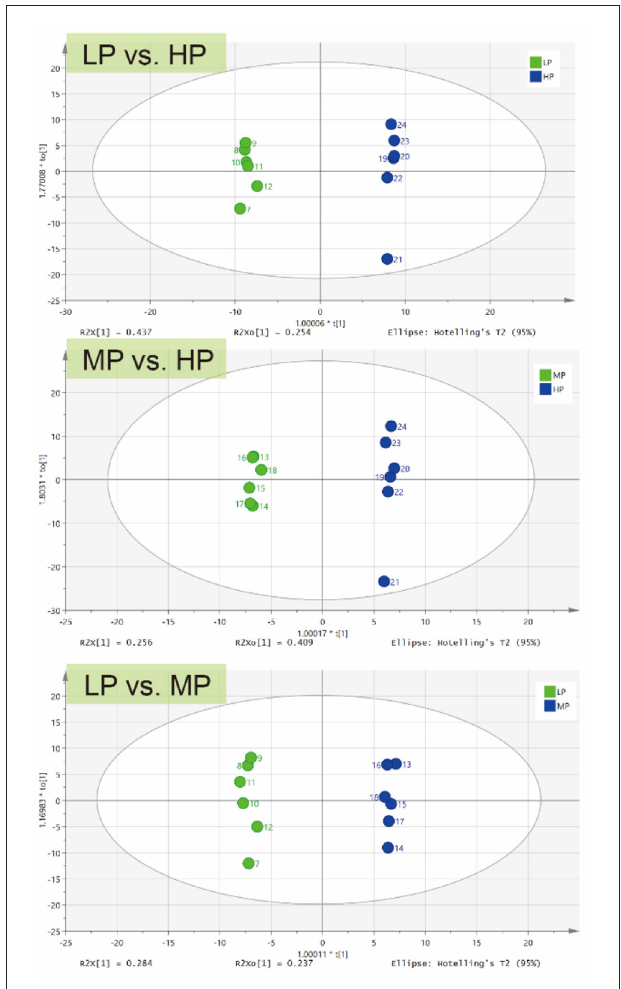
FIGURE 3 | OPLS-DA of ruminal metabolites between different groups.